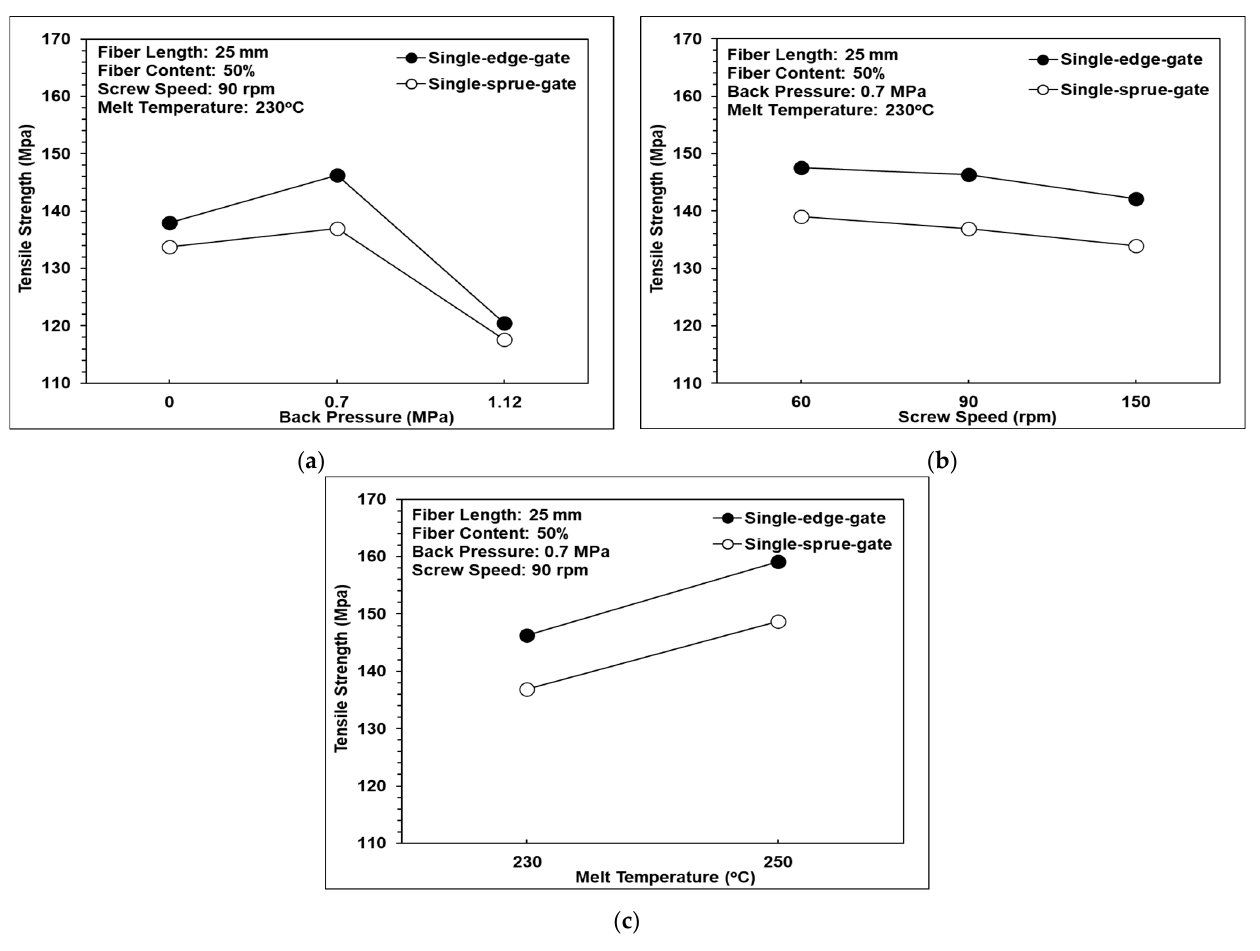
Figure 16. Effects of the different melt flow paths on tensile strength: ( a ) back pressure variations, ( b ) screw speed variations, and ( c ) melt temperature variations.